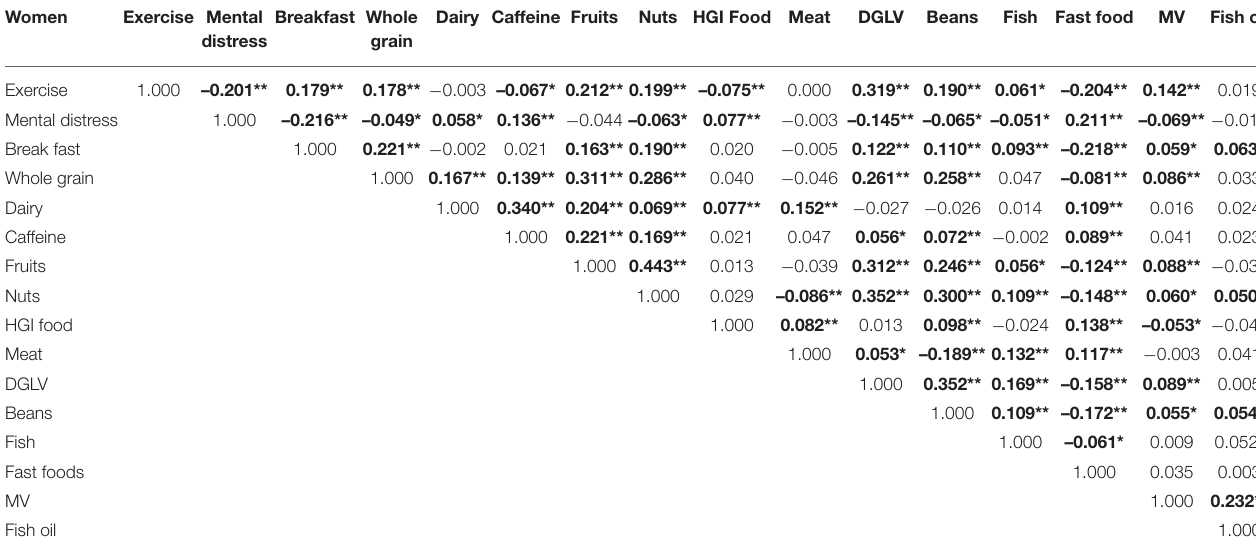
TABLE 6 | Spearman’s rho correlational analysis results for women.